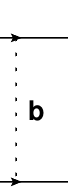
Figure 7: In the Regge limit of 2 → 2 scattering, the incoming particles barely glance off each other, thus follow straight-line trajectories separated by an impact parameter b